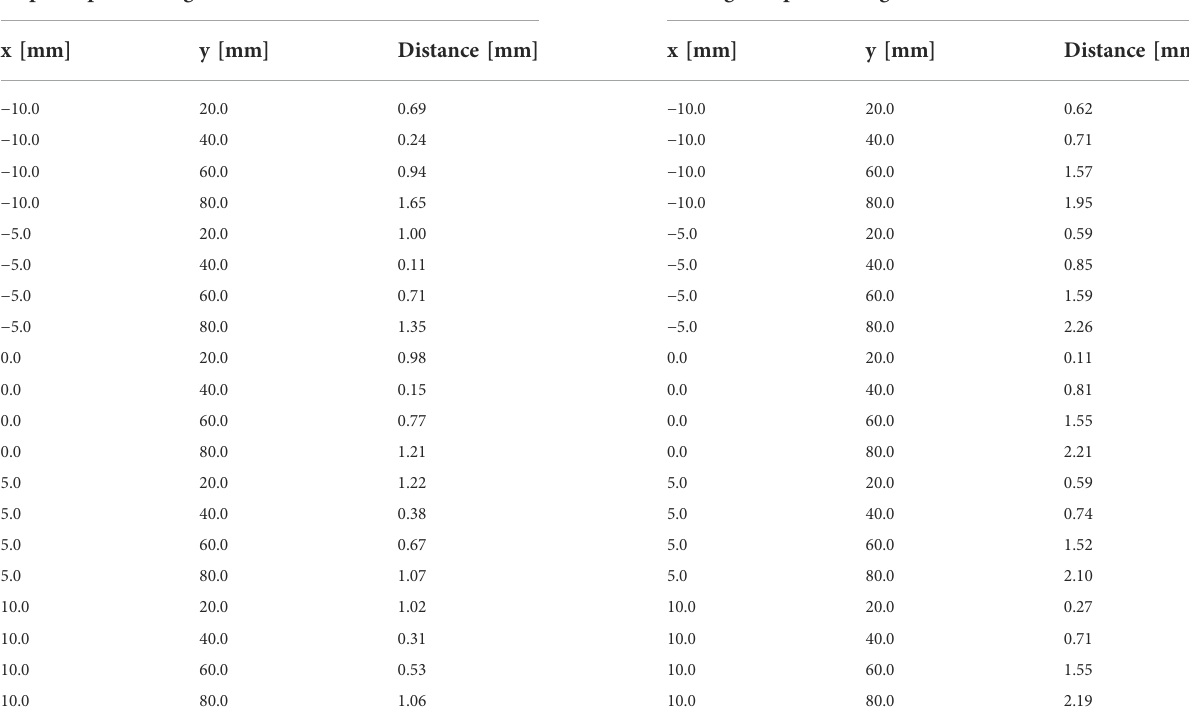
TABLE 2 The 2D distance measurements for in-plane and orthogonal positioning in the water bath setup. The click positions of the planned targets are provided as x- and y-coordinates in mm. In-plane